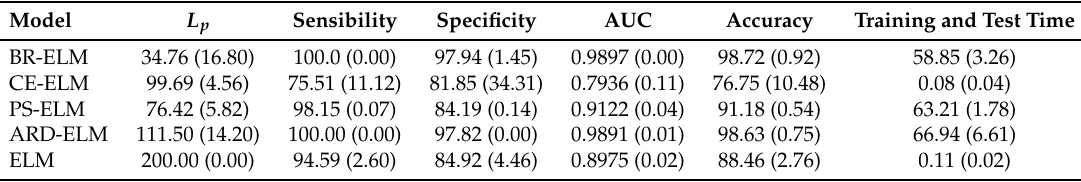
Table 15. Classification of fraud in